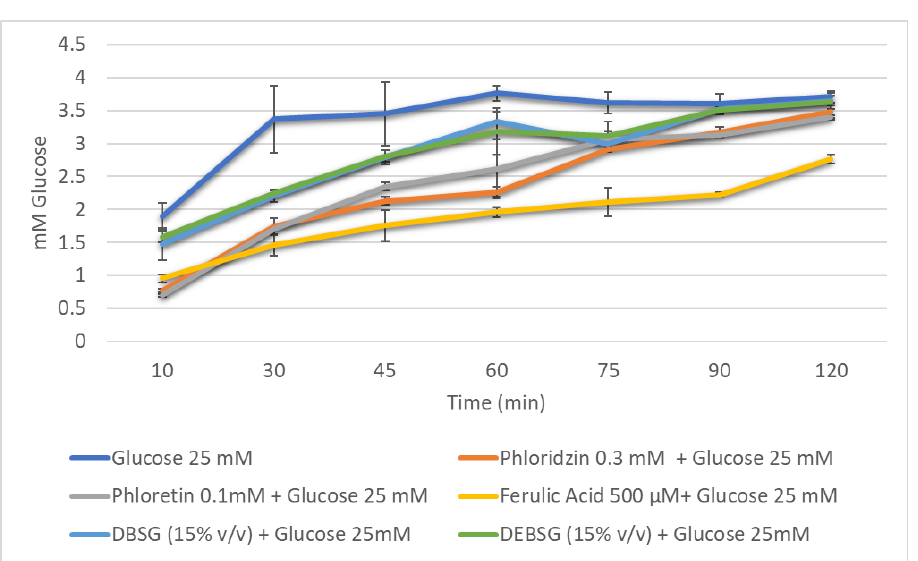
Figure 4. Glucose absorption in IEC-6 cells over time against reference inhibitors of glucose trans- porters (phloridzin and phloretin), ferulic acid, brewers’ spent grain intestinal digest (DBSG) and extruded brewers’ spent grain intestinal digest (DEBSG) under sodium-dependent conditions.